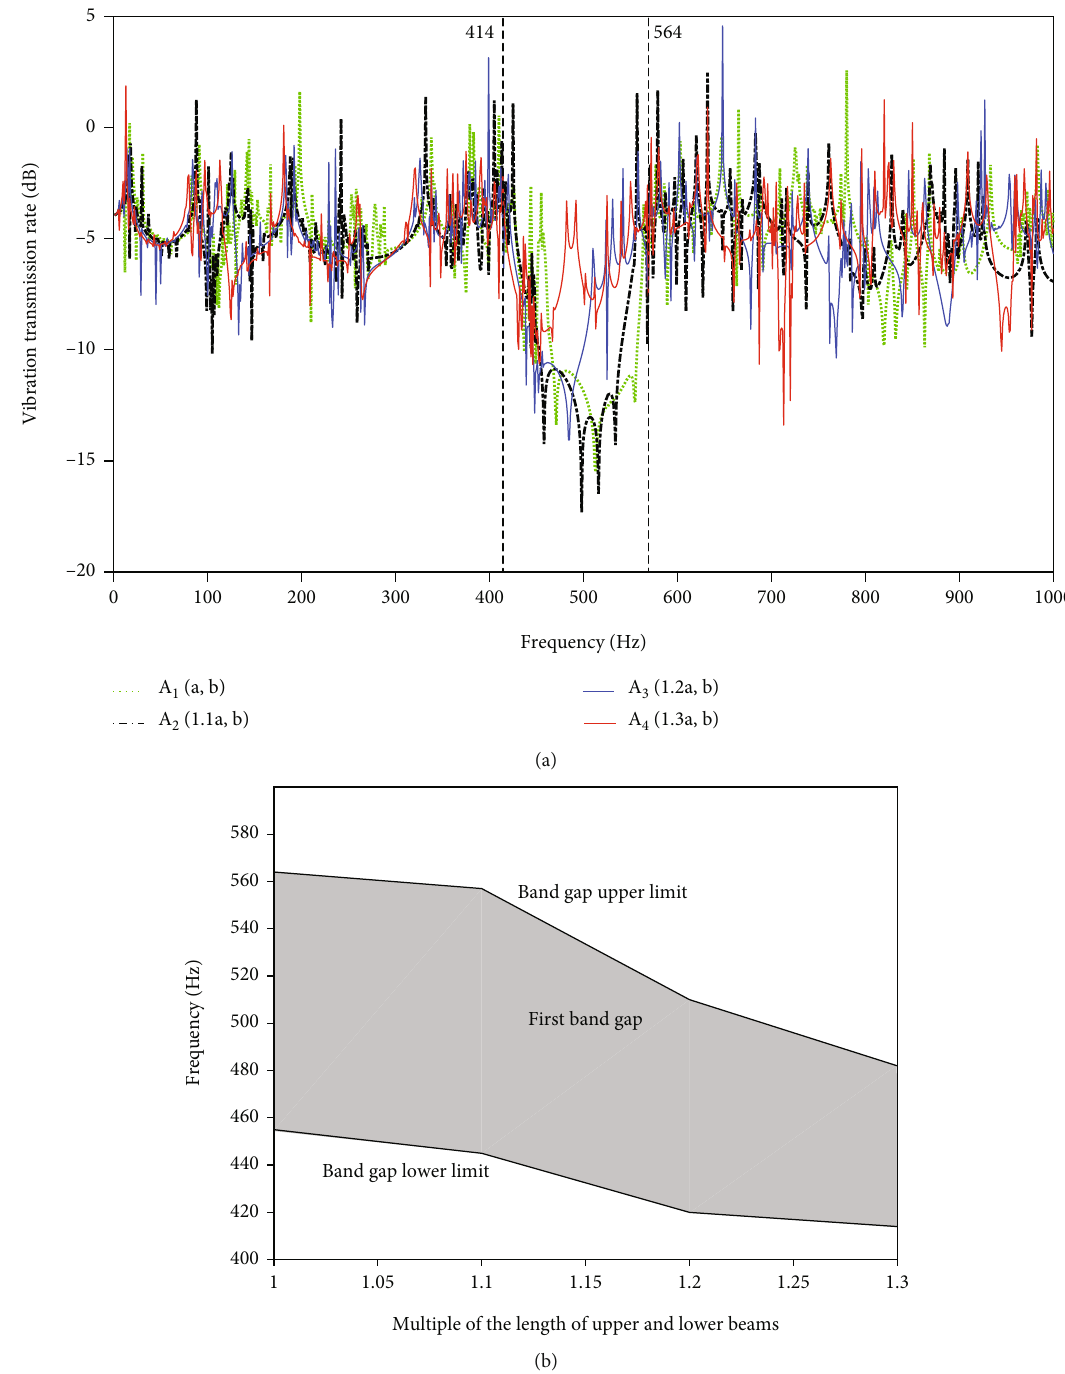
Figure 12: Corresponding to the change of the length of upper and lower chord beams: (a) vibration transmission rate of node R ; (b) the fi rst band